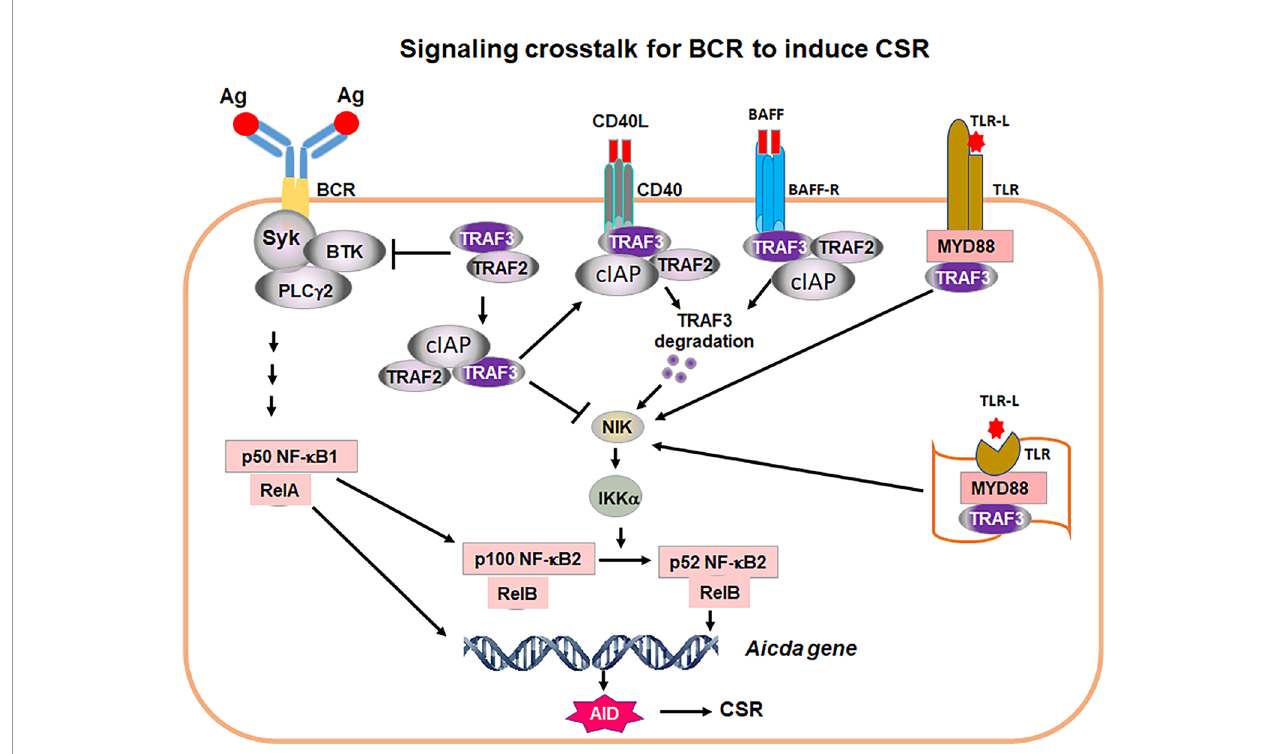
FIGURE 2 | A proposed model of signaling crosstalk for the BCR to induce CSR. Ag stimulation of BCR activates proximal signaling elements, Syk, BTK and PLC g 2, leading to transcription factor NF-kB1 activation. NF- k B1 p50/RelA complex is required for AID transcription. NF- k B1 p50/RelA also induces NF-kB2 p100 transcription. TRAF2/3 restrict BCR proximal signaling strength. TRAF2 and TRAF3 also block NIK activity. Thus, Syk/BTK/PLC g 2 complex cannot signal to generate transcription factor NF- k B2 p52 that is required for AID expression. Removal of TRAF3 and/or TRAF2 leads to NIK accumulation, which activates IKK a pathway, resulting in NF- k B2 p100 being processed into active NF- k B2 p52. NF- k B2 p52/RelB complex and NF- k B1 p50/RelA together with additional factors initiate AID transcription. AID protein initiates CSR by targeting Igh locus. During humoral immune responses, CD40, BAFF-R as well as cell surface and intracellular TLRs are activated by corresponding ligands, CD40L, BAFF or TLR ligand (TLR-L), respectively. TRAF3/TRAF2 are recruited to cell membrane where TRAF3 is degraded by CD40 and BAFF-R signaling or sequestrated by TLRs. As a consequence, NIK and NF- k B2 complex can be activated. NF- k B2 activation allows the BCR to induce CSR. Thus, the critical function of co-stimulatory signals is to degrade or sequestrate TRAF3 to permit NF- k B2-dependent BCR-induced CSR essential for in vivo antibody responses. It is worthy of note that TRAF3 restricts Syk, BTK and PLC g 2 hyper-activation upon Ag stimulation that may be especially important for maintaining autoreactive B-cell